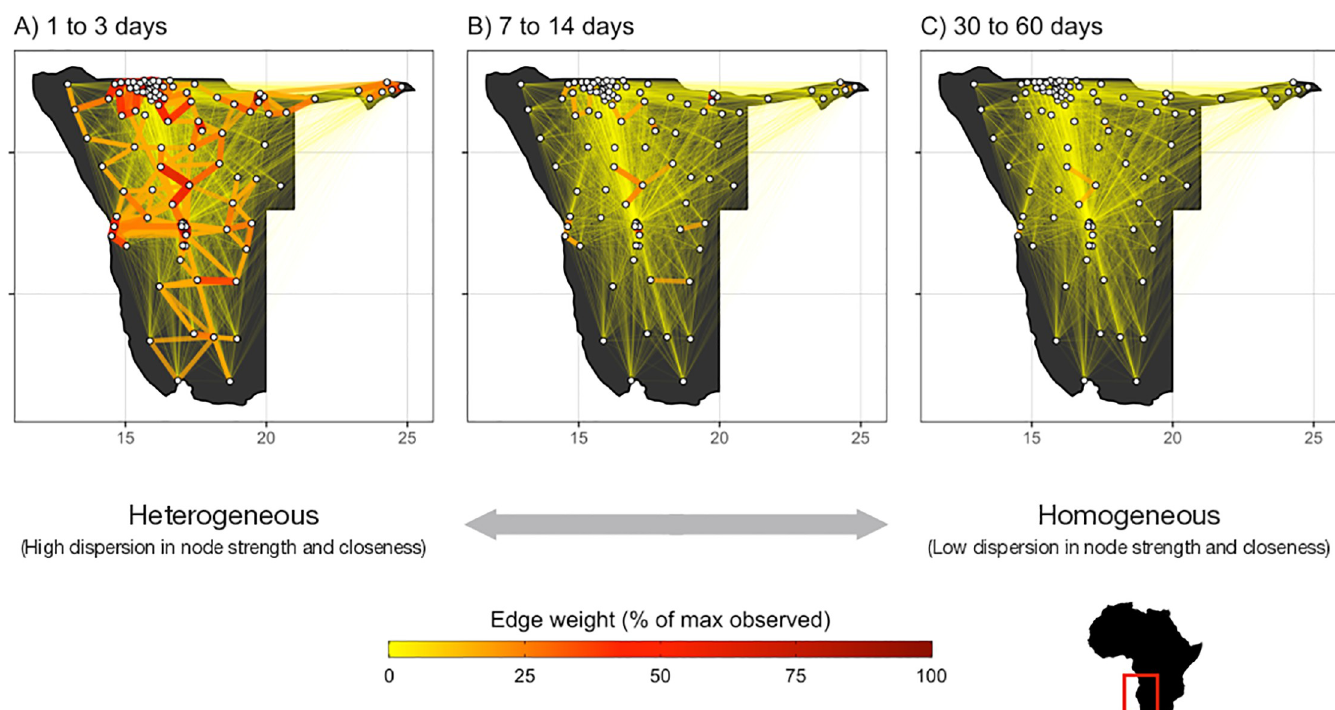
Fig 2. Travel network topology shifts from heterogeneous to homogeneous as trip duration increases. Maps of Namibia with travel volumes between districts that fall within three broad intervals of trip duration: A) 1–3 days, B) 7–14 days, and C) 30–60 days. For comparison, connectivity is defined as relative edge weight from 0 to 100%, which is calculated by scaling trip volume along the edges in each sub-network by the overall maximum trip volume observed in the full travel network. District centroids (nodes of the network) are indicated by the white circles. Shapefiles were acquired from DIVA-GIS (www.diva-gis.org) and are reused here under the Creative Commons Attribution